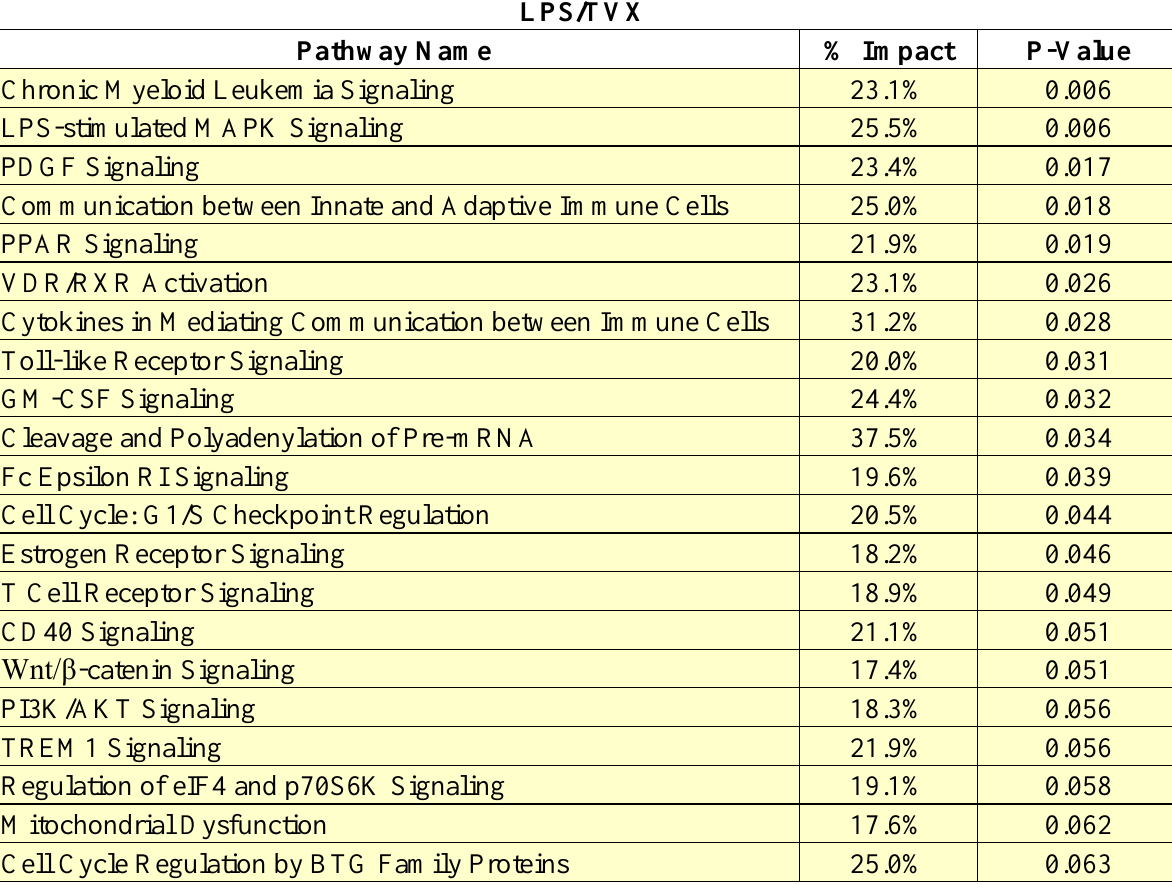
Table 3. List of Biochemical Pathways Regulated by LPS/TVX, but not by